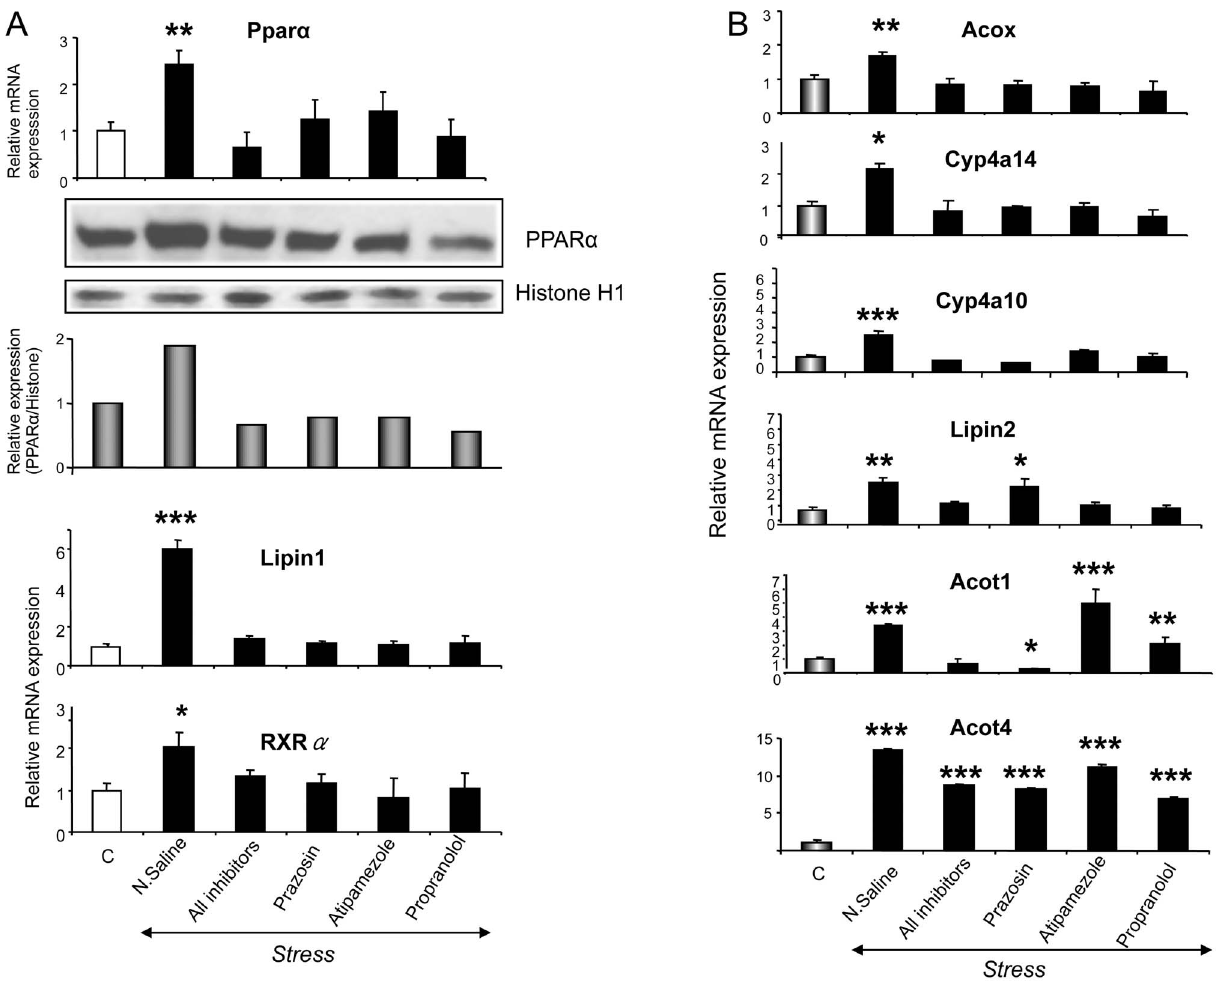
Figure 1. Stress-induced effect on PPAR a and target gene expression. A. Following exposure of wild-type mice to restraint stress, Ppara mRNA levels were examined by qPCR analysis in their liver and PPAR a protein was measured in the nuclear fraction by Western Blot analysis. Histone H1 served as a loading control. B. Acox, Cyp4a10, Cyp4a14, Lipin2, Acot1 , Acot4 , Lipin1 and RXR a mRNA levels were also analyzed by qPCR in wild-type mice. Values were quantified using the comparative CT methods normalized to b -actin and are expressed as mean 6 SE (n=8–10). Comparisons were between controls and stress-exposed mice (alone or previously treated with the AR-antagonists, prazosin, propranolol or atipamezole). Group differences were calculated by one-way ANOVA, followed by Bonferonni’s test. * P , 0.025, **P , 0.01, ***P , 0.001.